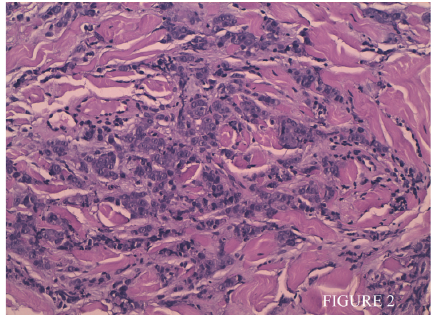
Figure 2: Infiltration of deep dermis syncytial groups of large cells with vacuolated clear cytoplasm and vesicular nuclei.